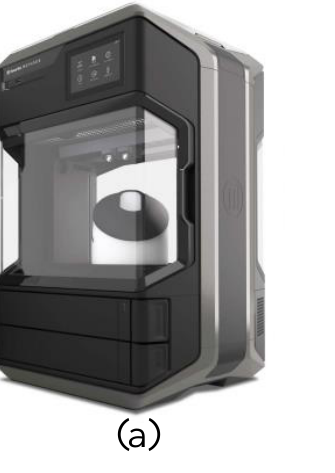
Figure 3. Experimental setup: ( a ) MakerBot method x carbon fiber edition [27], ( b ) Fluke 434 ii power analyzer [28], and ( c ) 3D model of a cube (10 mm × 10 mm × 10 mm) .